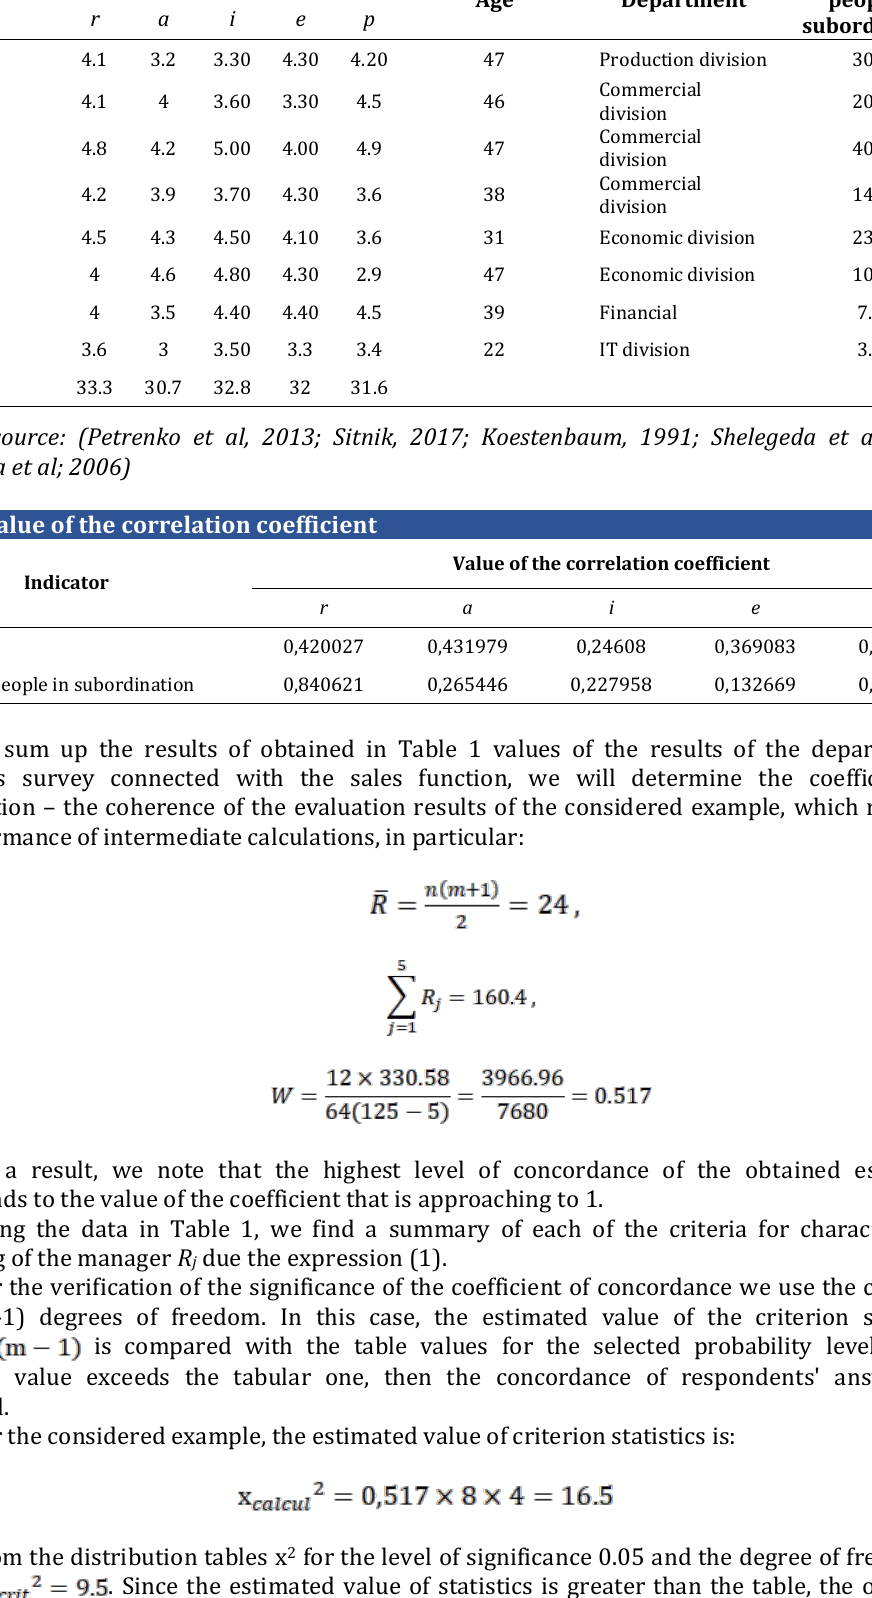
Table 1: Results of evaluation of managers Respondents